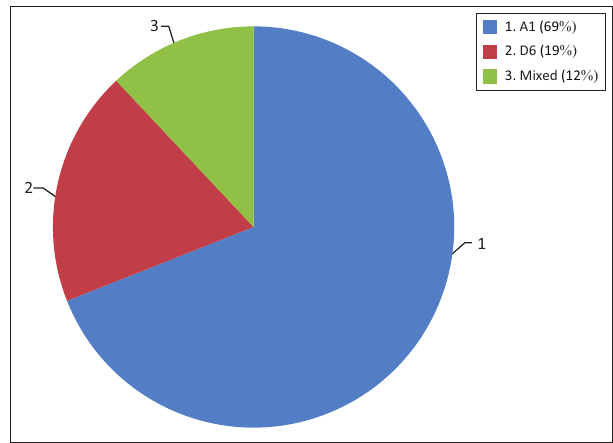
FIGURE 1: Hepatitis B virus subgenotypes isolated from Kenyan drug